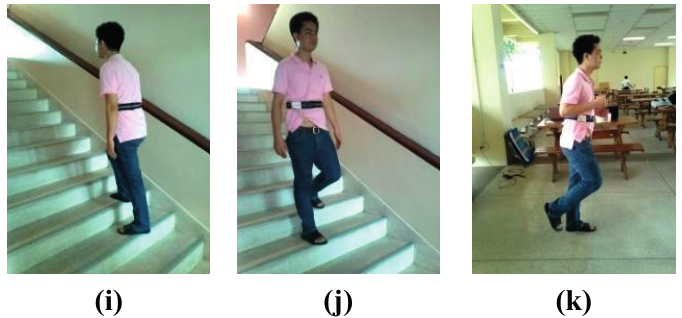
Figure 3. Dynamic activities performed by young subjects (DS2): ( a ) up and down movement of the right arm; ( b ) up and down movement of the left arm; ( c ) up and down movement of both arms; ( d ) jumping; ( e ) twisting left-right-left body movement at the waist; ( f ) bending forward; ( g ) bending backward; ( h ) walking; ( i ) walking up stairs; ( j ) walking down stairs; and ( k ) jogging.